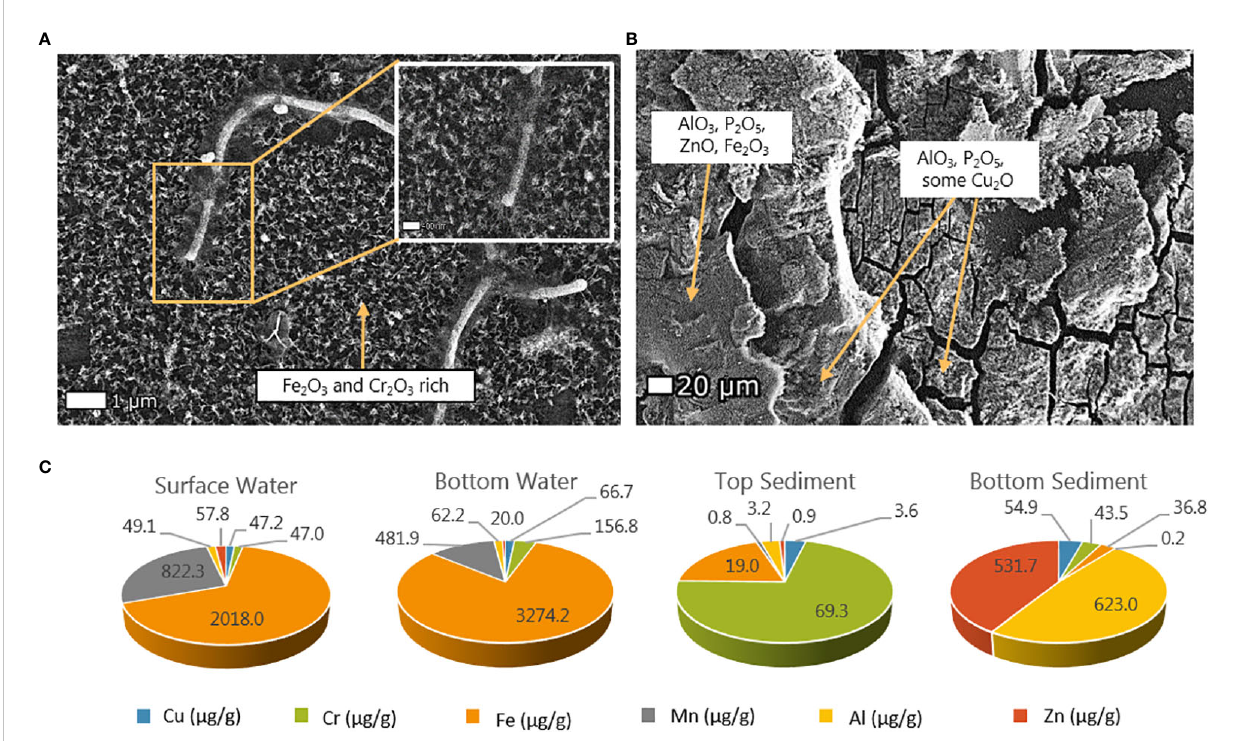
FIGURE 4 Metal sorption onto polyethylene (PE) exposed in Svanemøllen Harbor to (A) the water column (1 m) and (B) the sediment (12-14 cm depth). Mineral morphology suggests abiotic mineral formation of iron, chromium, alumina, zinc and copper oxides as well as phosphate determined via SEM-EDS. (C) Relative metal concentrations [µg/g] on PS exposed to surface water, top sediment and bottom sediment after 12 months exposure.